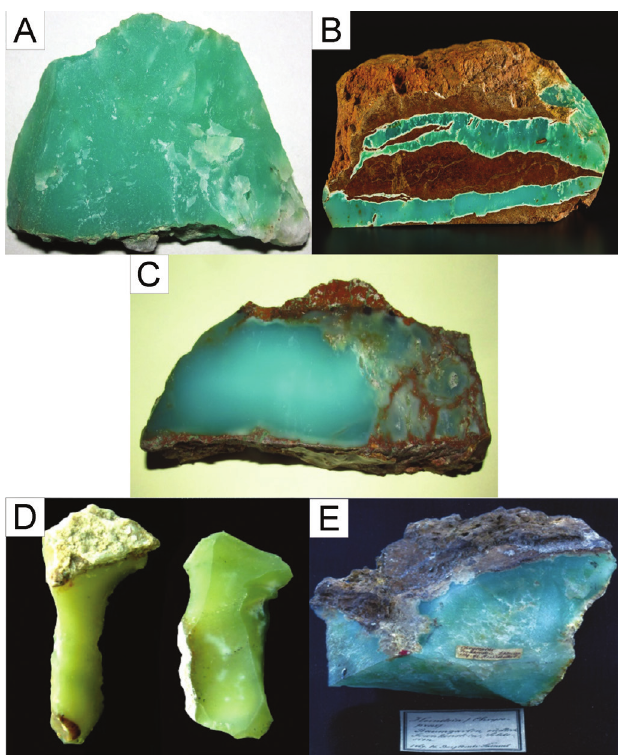
Figure 2. Chrysoprase from selected occurrences in the world: A – Australia. Photo by J. St. John, 2018, Wikimedia Commons; Creative Commons Attribution-Share Alike 4.0 International license; B – Tan - zanian emerald green chrysoprase. Collection of the Mineralogical Museum of the University of Wrocław. Photo by P. Piotr Rachwał; C – Sarykul-Boldy, Kazakhstan. Collection of the Fersman Mineralogical Museum of Fersman in Moscow; D – Neolithic chrysoprase blade, Suhaila, Ras al Khaimah Emirate. Photo by V. Charpentier; E – The oldest specimen of chrysoprase from Braszowice, Lower Silesia, found in 1869. Mineralogical Museum of the University of Wrocław. Photo by P.